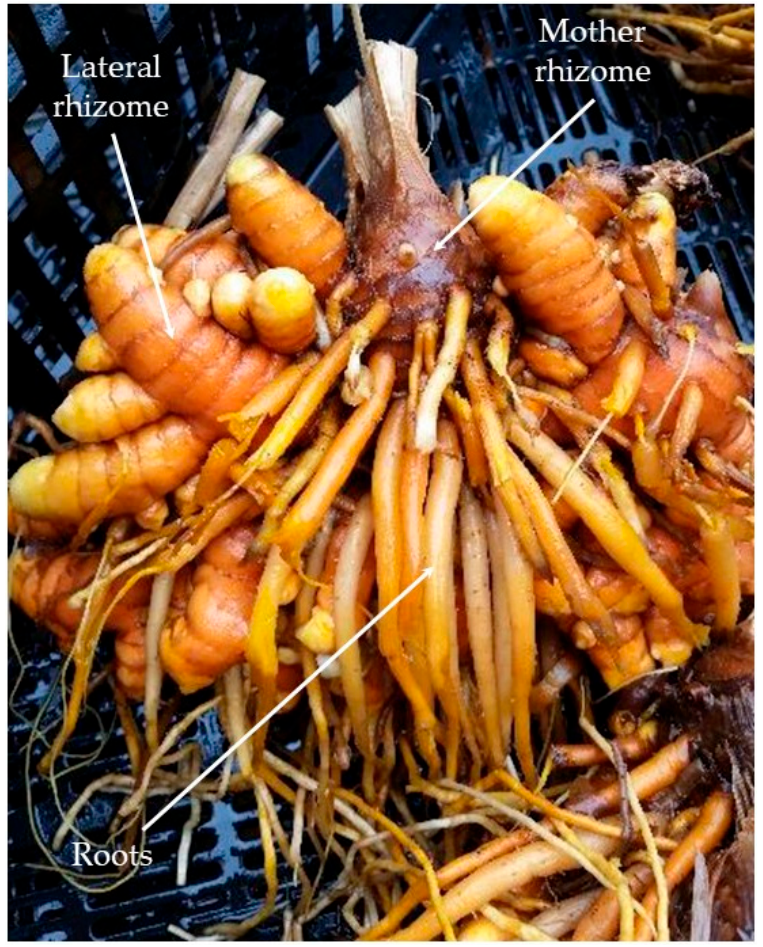
Figure 1. Underground parts of Curcuma longa showing the rhizomes and roots.